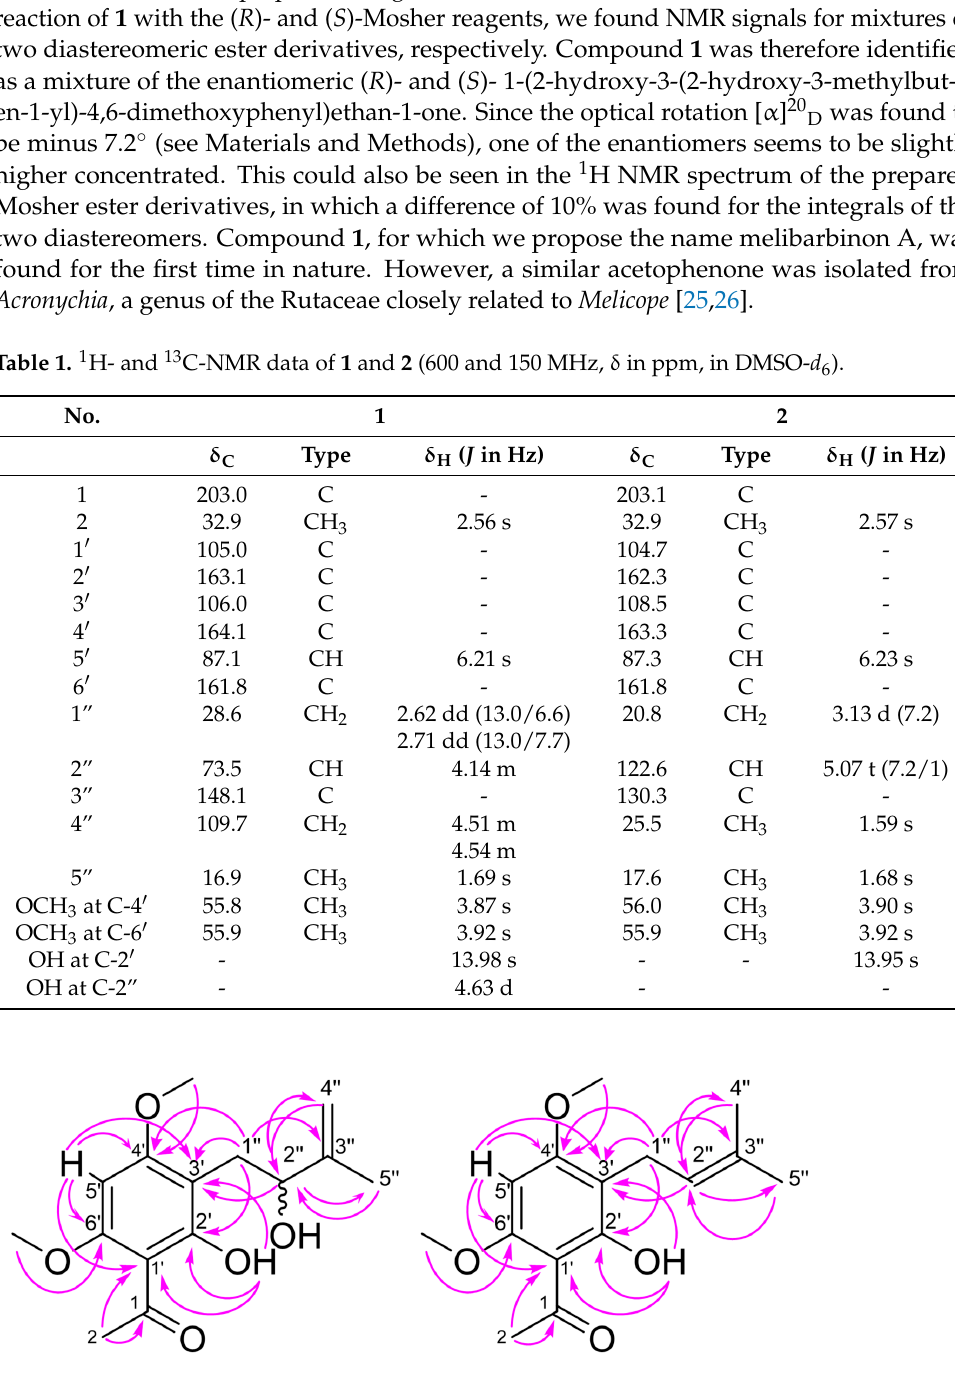
Figure 2. Key correlations of 1 and 2 in the HMBC spectrum. The molecular formula of 2 (C 15 H 20 O 4 ) , determined by HRESIMS analysis, indicated the loss of one oxygen atom compared to 1 . The 13 C NMR spectrum of 2 also displayed 15 carbon signals at shift values similar to 1 . Differences were only found for the signals of the prenyl side chain and the aromatic carbon C-3 ′ ( δ 108.5), where the side chain is at- tached. Instead of one methyl group, one unsaturated methylene and one aliphatic hy- droxyl group, we found the signals for two methyl groups at δ 1.59 (s, H-4 ″ ) and δ 1.68 (s, H-5 ″ ) together with one proton at δ 5.07 (t, H-2 ″ ) indicating the presence of a 3-methyl- but-2-en-1-yl side chain, found in many prenylated natural products such as O-prenylated acetophenones from M. obscura and M. obtusifolia or the prenylated benzene pteleifolins A isolated from M. pteleifolia [27,28]. The structure was additionally confirmed by the corre- lations found in the 2D-NMR spectra (see Figure 2). This compound was also found for the first time in nature, but it was already described as intermediate in the synthesis of 4 ′ - O -methylxanthohumol [29]. However, its completely assigned NMR data are given here for the first time. In analogy to 1 , we propose the name melibarbinon B for 2 . Compound 3 was isolated as a yellow oil. The molecular formula was established as C 19 H 24 O 4 , indicating 6 degrees of unsaturation. The 1D-and 2D-NMR spectra of 3 (Table 2) showed the presence of a benzopyran moiety as found in alloevodionol ( 5 ) [21]. In com- parison to the signals found in the spectra of 5 , the carbon signal of C-2 ( δ 80.9) was slightly shifted upfield and the signal for two equivalent methyl carbons attached to C-2 in 5 was replaced by one methyl group (C-13, δ 26.7) and one methylene group (C-14, δ 41.7). This was confirmed by the 3 J-Korrelation between H-3 (d, δ 5.38) of the chromene moiety in 3 with both methyl and methylene carbons. Thus, C-14 was found to be substituted by a prenyl side chain, showing typical proton and carbon shift values (Table 2). All signals were assigned by their correlations in the 2D-COSY, HMQC, and HMBC spectra of 3 (see Figure 3). The structure of 3 was found to be 1-[7-hydroxy-5-methoxy-2-methyl-2-(4- methylpent-3-en-1-yl)-2 H -1-benzopyran-8-yl]ethan-1-one, previously described as inter- mediate in the chemical synthesis of boesenbergin A, a natural constituent of Boesenbergia rotunda (Zingiberaceae) [30]. However, 3 was found here for the first time in nature, so we suggest the name melibarbichromen A for this new natural compound. Figure 3. Key correlations of 3 in the HMBC spectrum.